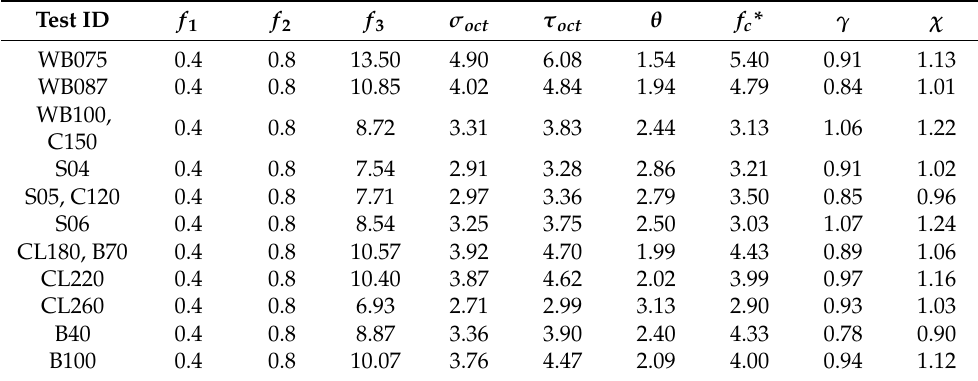
Table 9. Normal stress, shear stress and Lode’s angle in octahedral stress space under (0.4 MPa, 0.8 MPa).